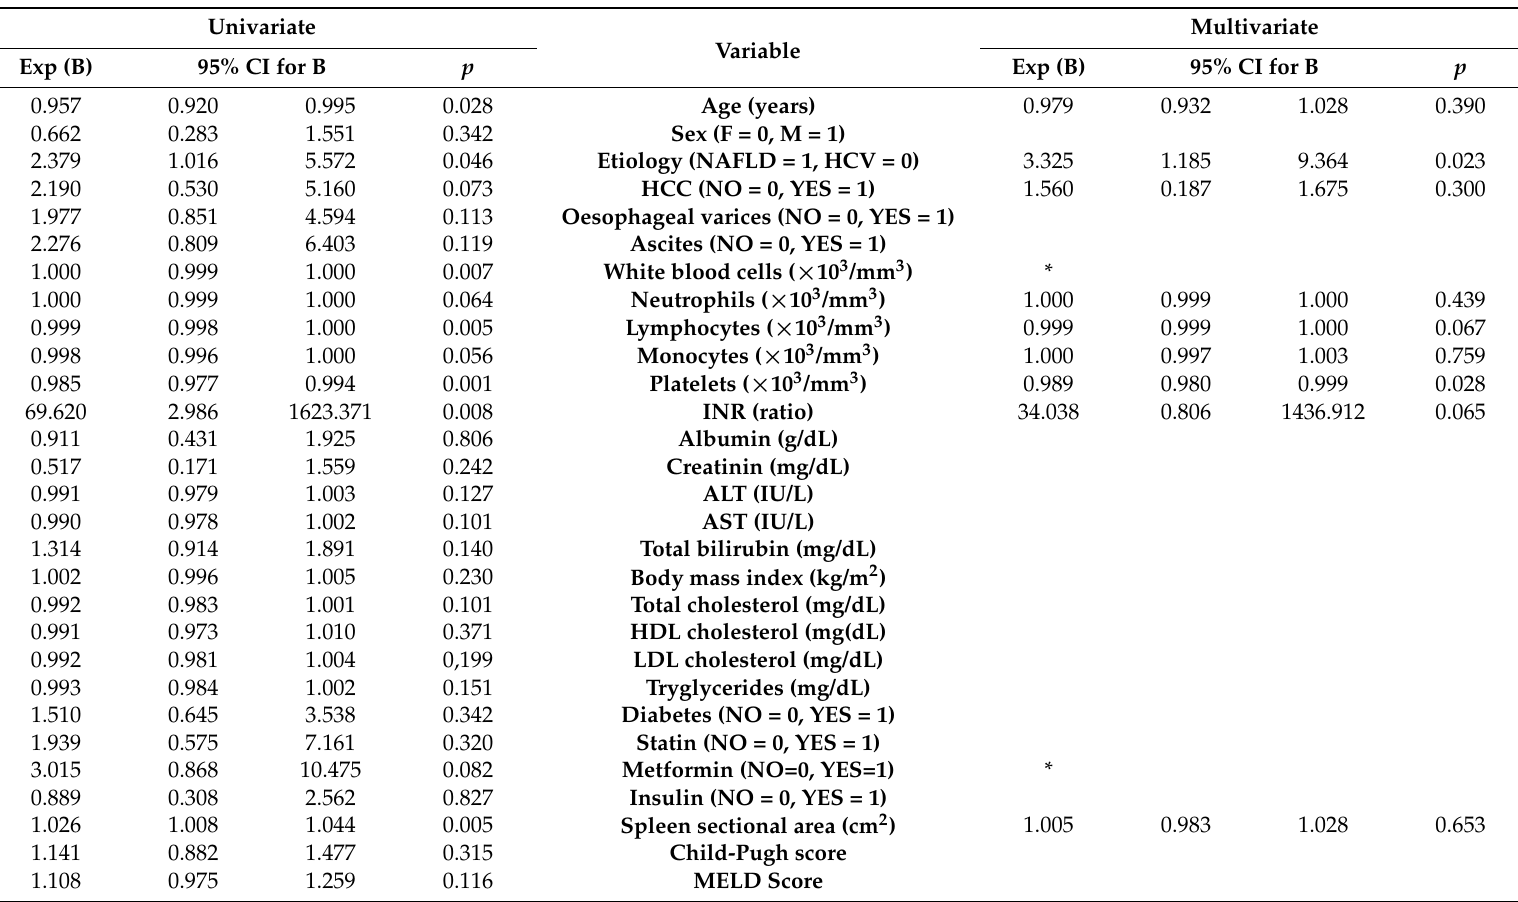
Table 4. Univariate and multivariate binary logistic regression analysis to lysosomal acid lipase (LAL) in the subgroup of cirrhotic patients (performed using LAL below median as the dependent